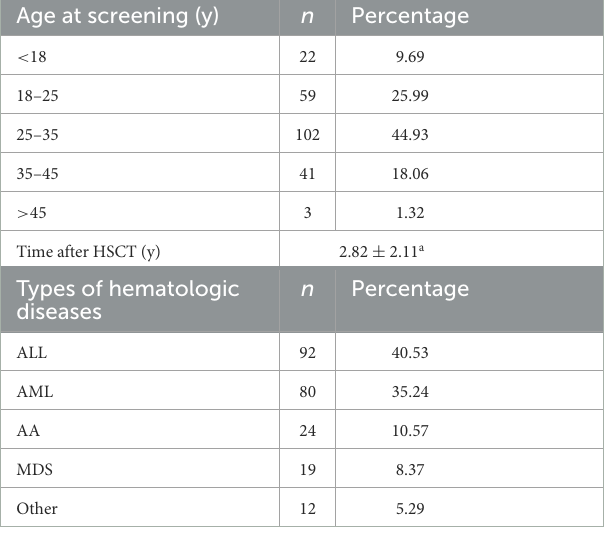
TABLE 1 Demographic and clinical characteristics of the participants after HSCT ( N =